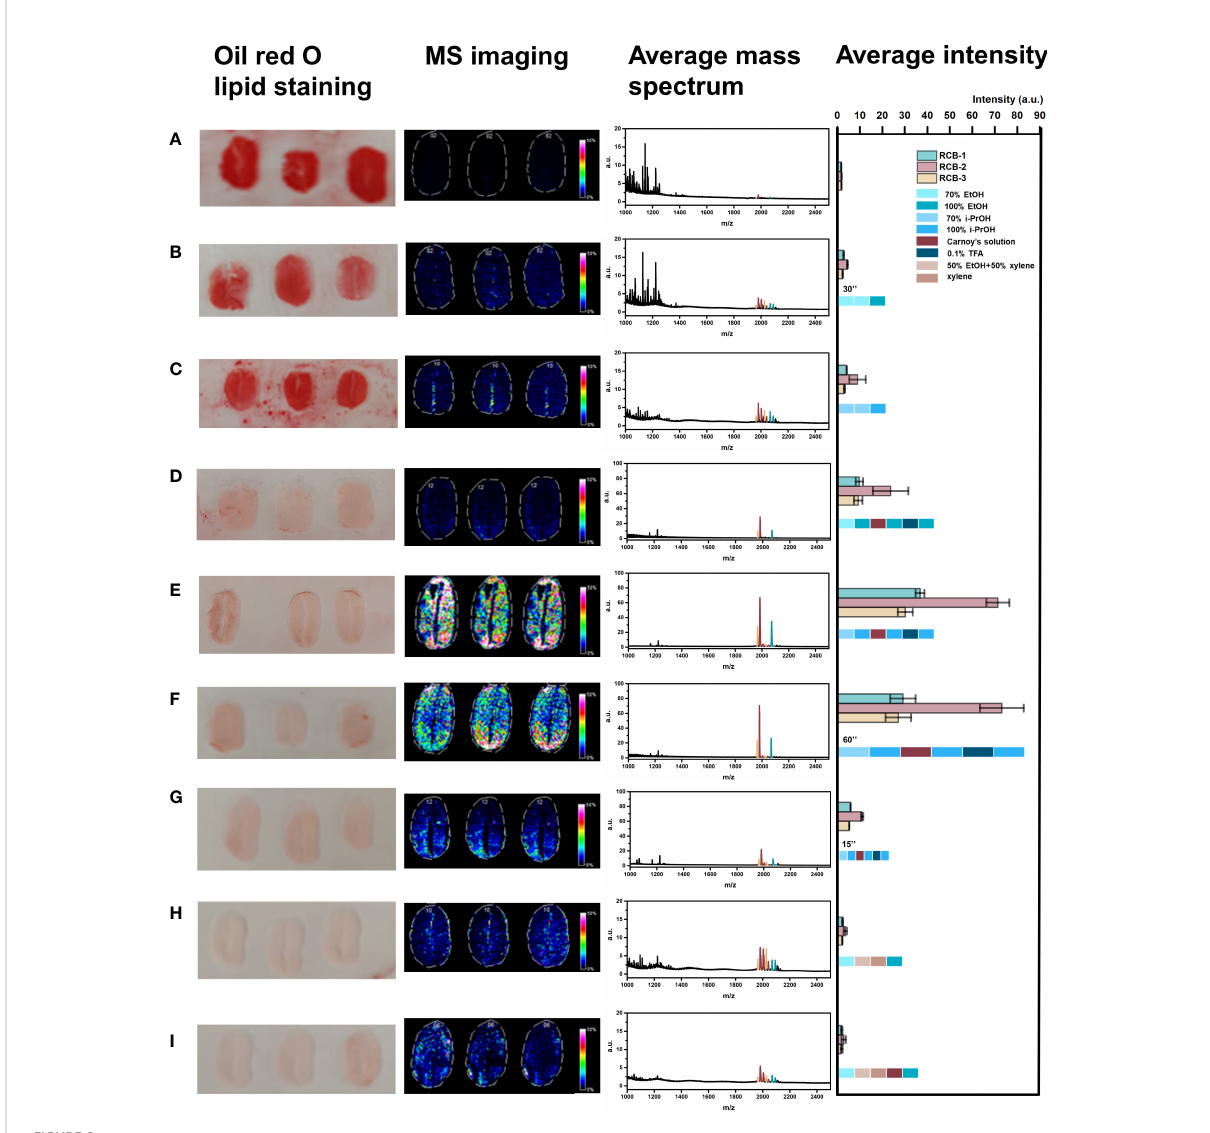
FIGURE 2 Comparison of different washing protocols. (A) No wash; (B) Wash with 70% ethanol, 70% ethanol, 100% ethanol for 30 s, respectively; (C) Wash with 70% isopropanol, 70% isopropanol, 100% isopropanol for 30 s, respectively; (D) Wash with 70% ethanol, 100% ethanol, Carnoy ’ s solution ⃰ , 100% ethanol, 0.1%TFA, 100% ethanol for 30 s, respectively; (E) Wash with 70% isopropanol, 100% isopropanol, Carnoy ’ s solution, 100% isopropanol, 0.1%TFA, 100% isopropanol for 30 s, respectively; (F) Wash with 70% isopropanol, 100% isopropanol, Carnoy ’ s solution, 100% isopropanol, 0.1%TFA, 100% isopropanol for 60 s, respectively; (G) Wash with 70% isopropanol, 100% isopropanol, Carnoy ’ s solution, 100% isopropanol, 0.1%TFA, 100% isopropanol for 15 s, respectively; (H) Wash with 70% ethanol, 1:1(v/v) mixture of ethanol and xylene, xylene, 100% ethanol for 30 s, respectively; (I) Wash with 70% ethanol, 1:1(v/v) mixture of ethanol and xylene, xylene, Carnoy ’ s solution, 100% ethanol for 30 s, respectively. (*Carnoy ’ s solution= 60% (v/v) ethanol, 30% (v/v) chloroform, 10% (v/v) glacial acetic acid)